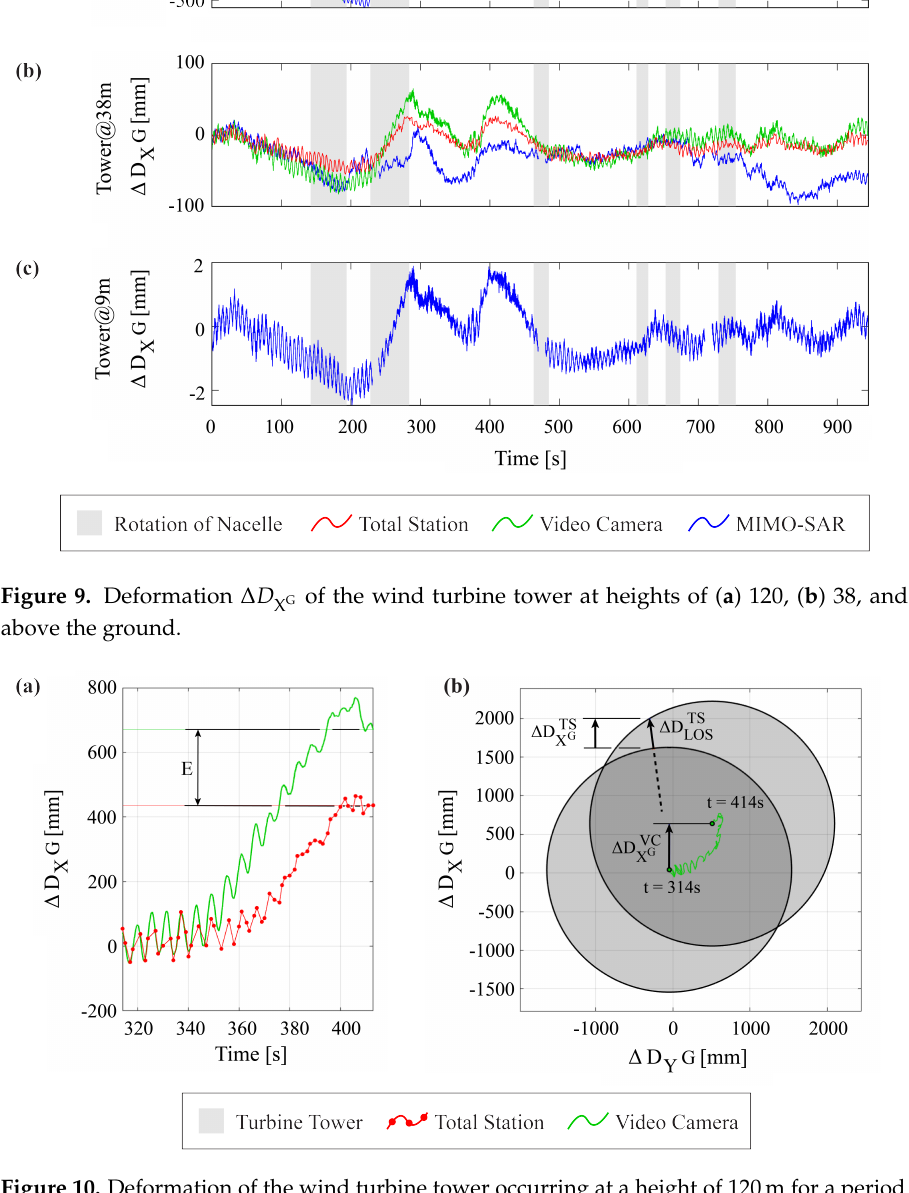
Figure 10. Deformation of the wind turbine tower occurring at a height of 120m for a period of 100s starting with epoch t = 314s (zoom-in of Figure 9a). ( a ) Deformation ∆ D X G over time. ( b ) Location and diameter of the wind turbine tower at epochs t = 314s and 414s estimated from the video camera